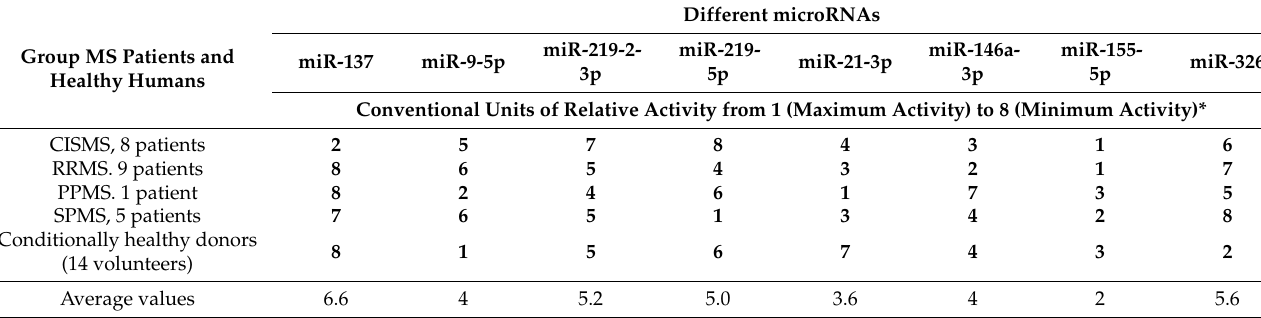
Table 2. Average relative activities of polyclonal IgGs from the sera of MS patients and conditionally healthy donors in the hydrolysis of eight different microRNAs by IgGs of different groups were ranked from the highest (digit 1) to lowest (digit 8) activity (more detailed data are given in Table